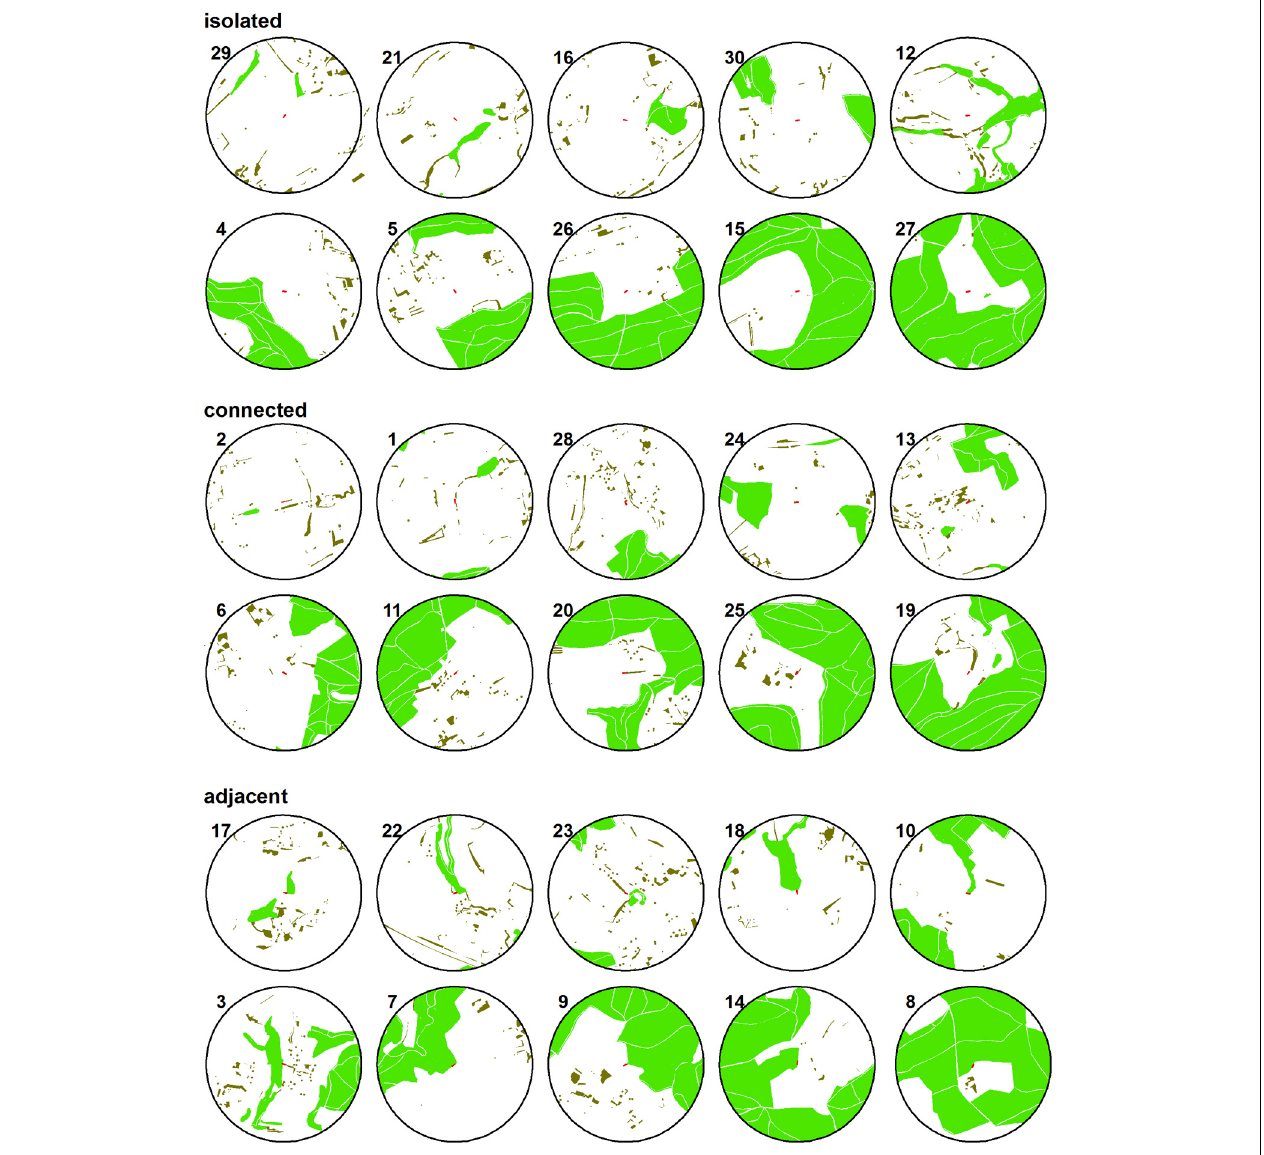
FIGURE 2 | Simplified maps of the study sites. Their numbers relate to Figure 1 . Light green: forest; dark green: small woods; red: study sites at the center of the 500m radius circles.